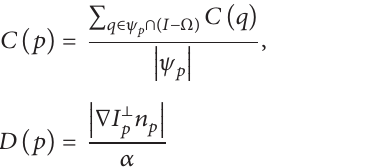
as possible information from outside of the region, in view of the restoration process (Figure 2). By using more known neighbors, the restoration can be achieved even within a single